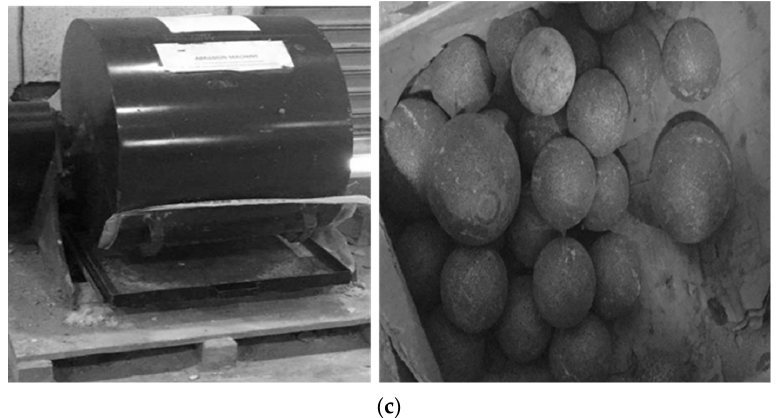
Figure 1. ( a ) Periwinkle shells; ( b ) crushed periwinkle shells; ( c ) laboratory ball milling crusher with steel balls.